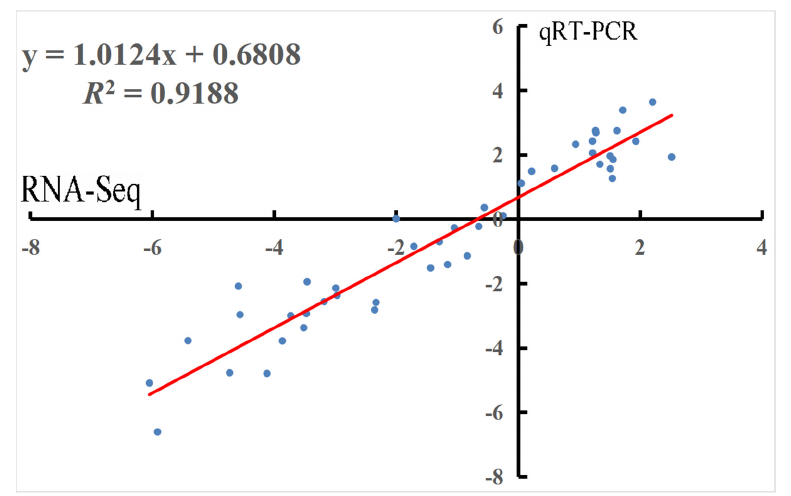
Figure 4. qRT-PCR validation of the transcripts between two treatments of grape berries during development and ripening..Correlation of fold change was analyzed by RNA-Seq (x axis) and the data were obtained using qRT-PCR (y axis). data were obtained using qRT-PCR (y